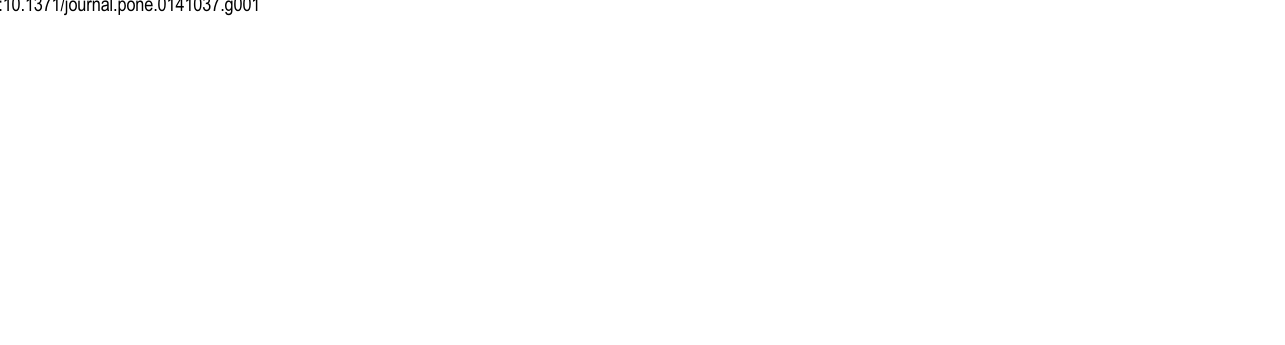
PLOS ONE | DOI:10.1371/journal.pone.0141037 October 15, 2015 2 /